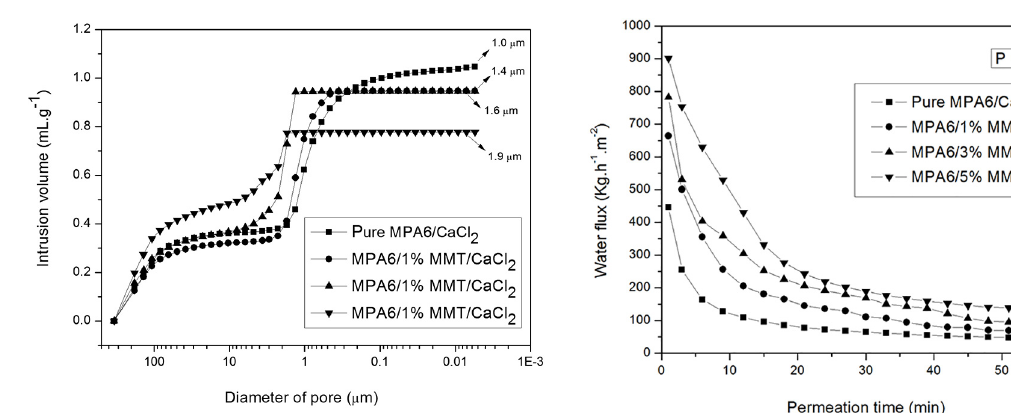
membrane: (a) top surface and (b) cross-section. 2